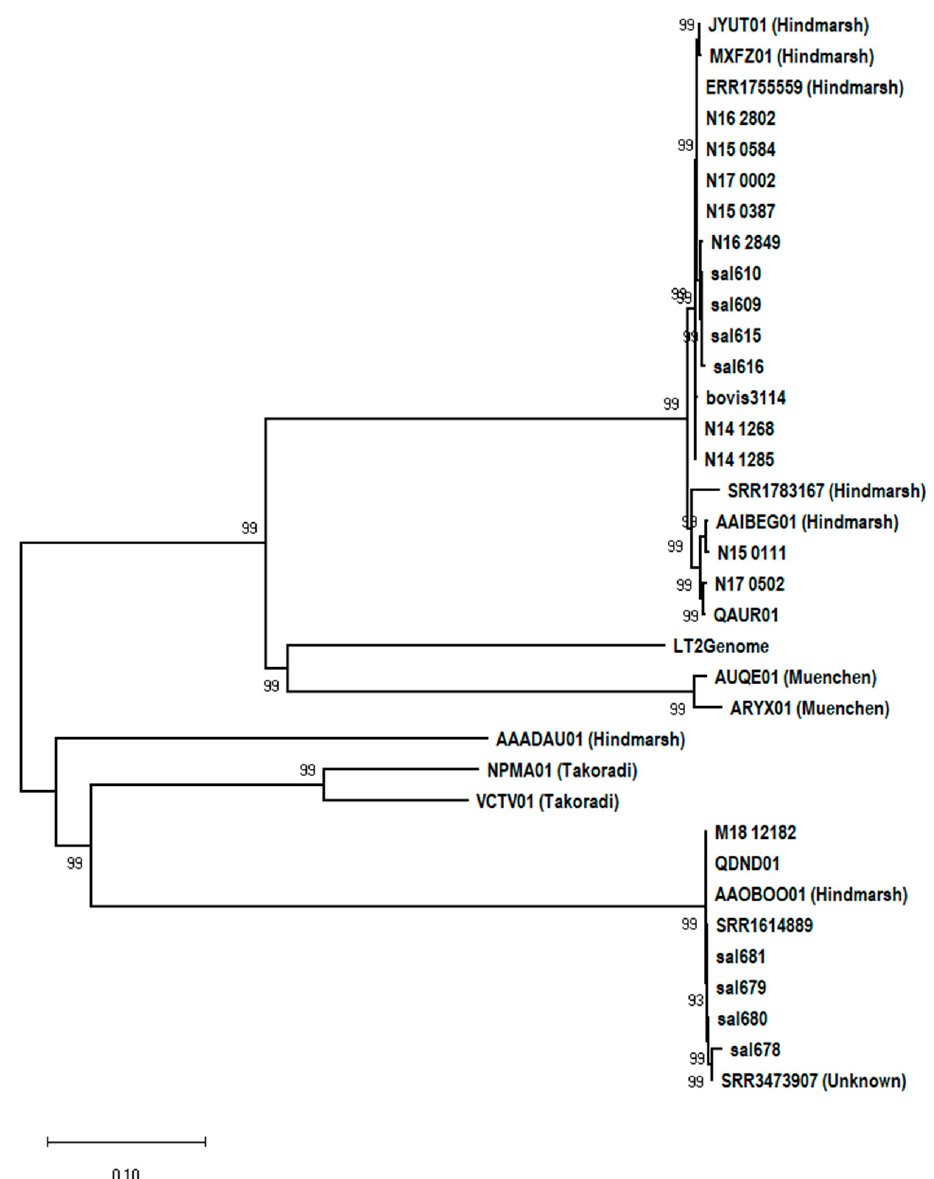
Figure 4. Phylogenomic profiling of S. Bovismorbificans and closely related serovars. S . Bovismorbificans is made up strains with two distinct genomic backbones, naturally grouped into two distant clusters. Cluster 1 strains are closer to S . Typhimurium (represented by the reference genome LT2) and S. Muenchen (AUQE01 and ARYX01) than to the Cluster 2 S . Bovismorbificans strains. WGS analysis from this study identified S . Takoradi (NPMA01 and VCTV01) as the closest serovar to the Cluster 2 S. Bovismorbificans strains. S . Hindmarsh strains sharing the antigen-cluster with S. Bovismorbificans in White–Kauffmann–Le Minor scheme also exhibit different genomic backbones as in the case of S. Bovismorbificans. Two of the Hindmarsh strains are aligned with Cluster 1 (SRR1783167 and AAIBEG01), while AAADAU01 and AAOBOO01 align within Cluster 2. For this analysis, Neighbor-Joining method implemented on MEGA X suite was used yielding a data matrix made up of 46,403 base positions across 35 genomes. MLST, DNA tiling Microarray (MA), whole genome sequence (WGS) based phylogenetic analysis, core-gene alleles spanning more than 2700 core genes, and k-mer binning based on NGS datasets and conventional assays all point to two divergent genome types bearing a single serotyping cluster. SRR3473907 was not clearly serotyped either by its NCBI BioSample record or by SeqSero in this